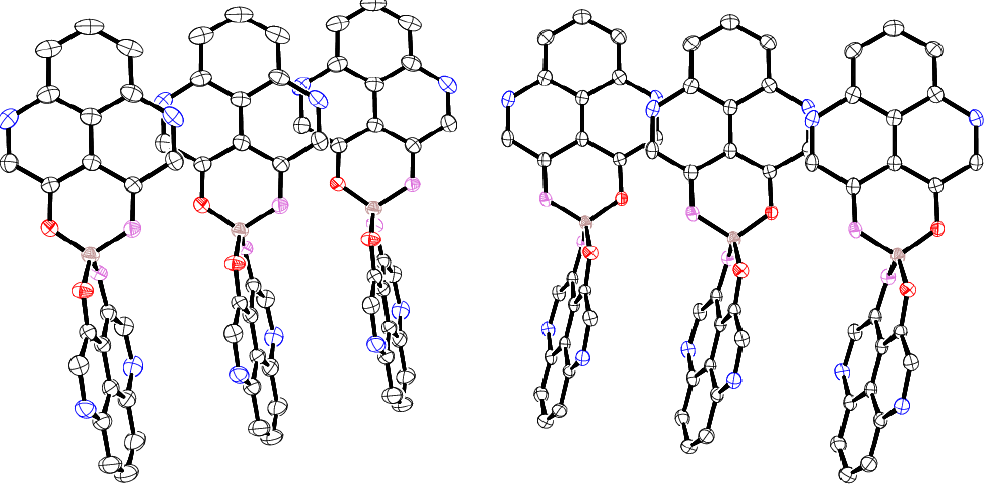
Figure 6. Super-position of a pair of spin bearing carbons per phenalenyl unit (viewed perpendicular to PLY ring) for radicals 7 ( left ) and 11 ( right ). Equivalent superimposed overlaps are observed for total four spin bearing carbons (blue color) per